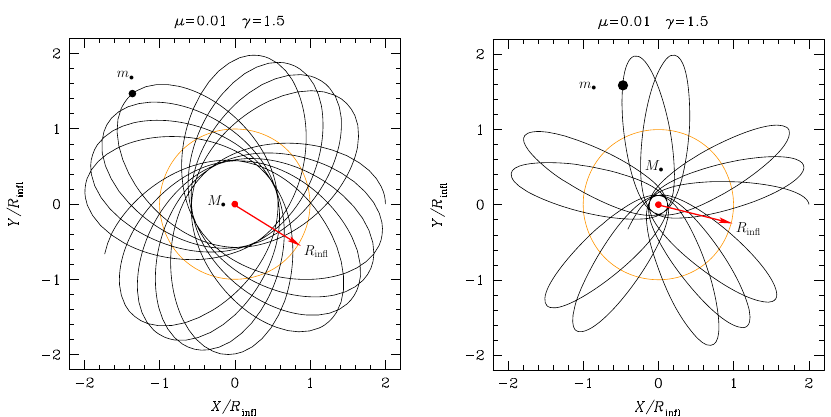
Fig. 8 Projection in the X–Y plane of the evolution of two test star orbits in a stellar system without relaxation. The central, orange point represents the position of the MBH, the black dots on the orbits the position of the test stars and the red arrow delimits the influence radius R infl of the MBH. The right panel represents a case with a larger eccentricity. The orbits extend further than the R